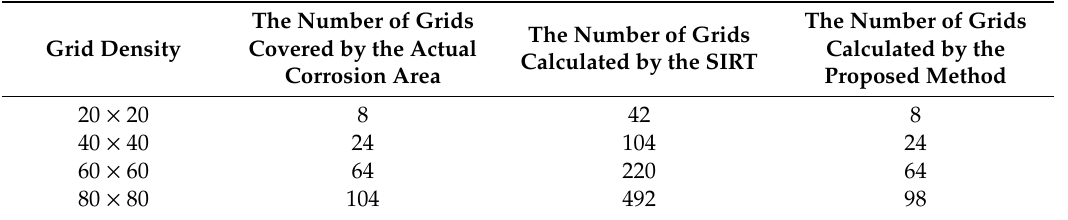
Figure 10. Tomographic reconstruction images for a 1.5 mm thick aluminum plate with two 20 mm diameter circular flat-bottomed holes with different grid density using the proposed method. Their thickness losses were respectively of 50% and 30% within the flaws. ( a ) The number of grids was 20 × 20, ( b ) the number of grids was 40 × 40, ( c ) the number of grids was 60 × 60, and ( d ) the number of grids was 80 × 80. Table 2. With different grid density, the number of grids covered by the actual corrosion area were compared to ones calculated respectively by SIRT and the proposed method.